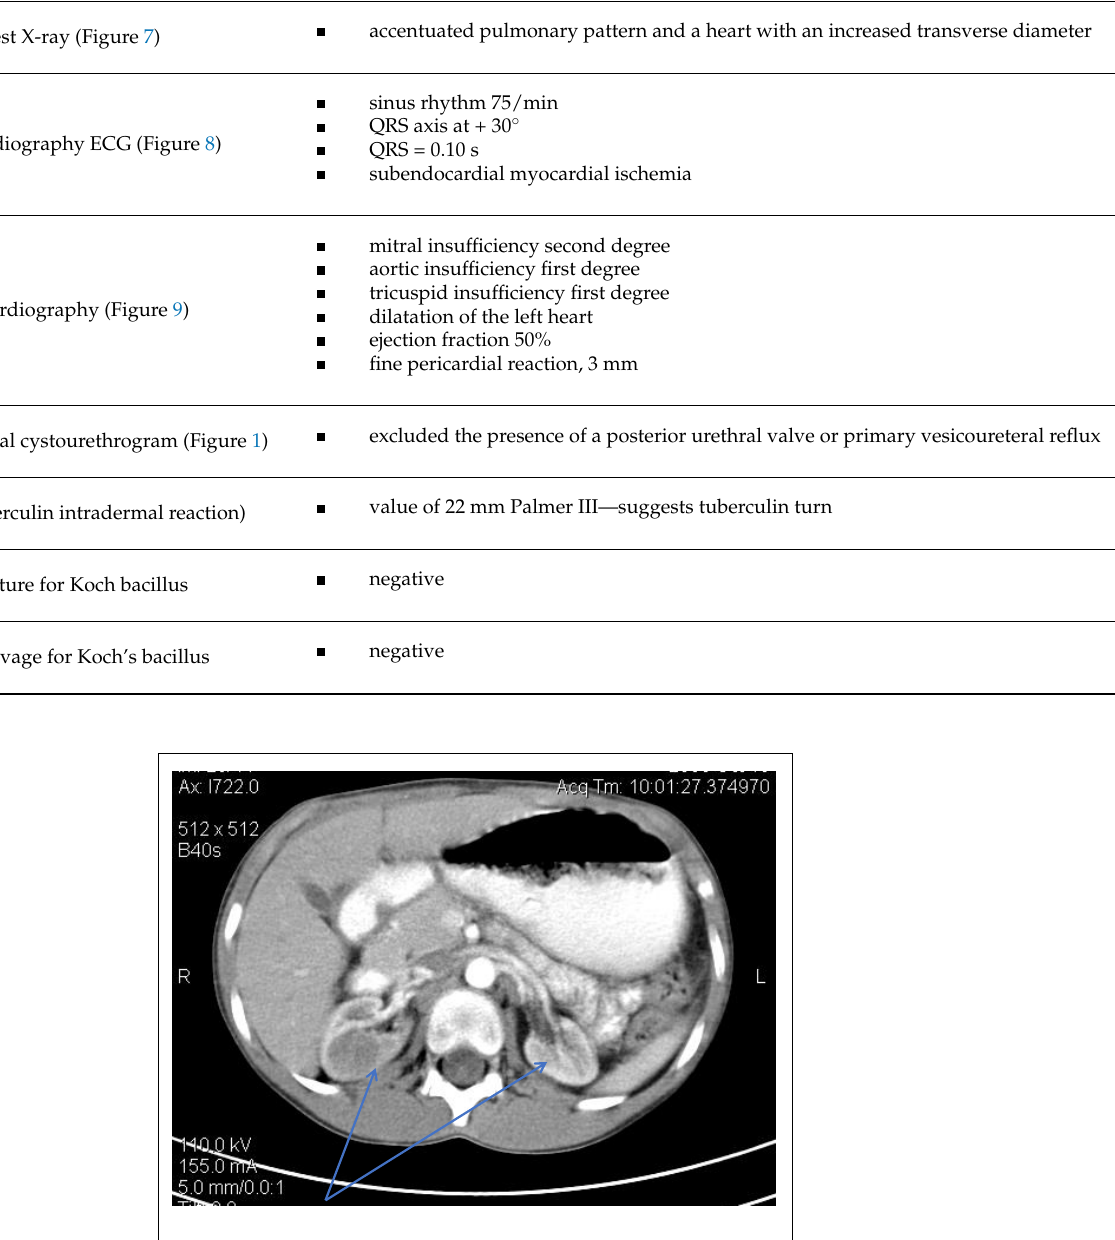
Figure 3. Kidney biopsy ( hematoxylin - eosin staining × 100)—Glomeruli and hyalinized vessels (blue arrow).